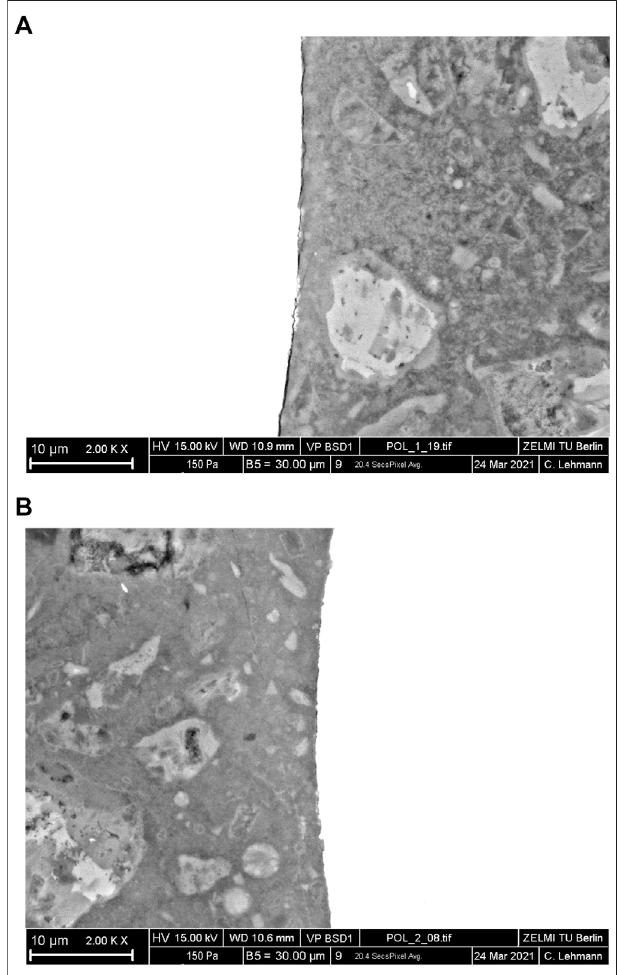
FIGURE 7 | SEM images on the interface between steel fi bres and the matrix of autoclaved C1 (A) and C2 (B)